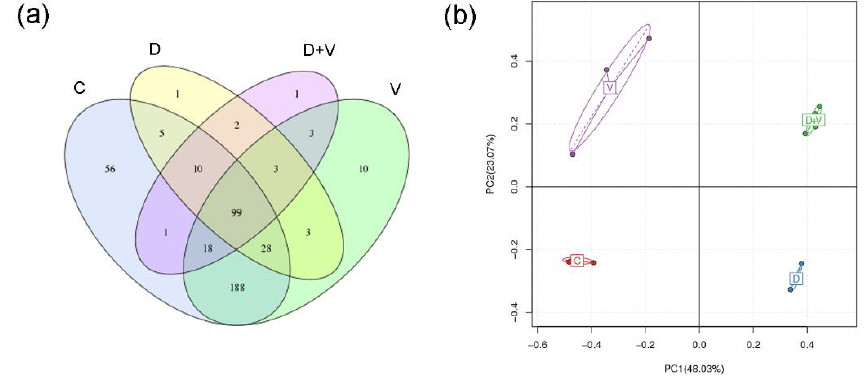
Figure 2. Operational taxonomic unit (OTU) cluster and abundance. ( a ) OTU Venn chart. Different colors represent different groups. The interior of each circle symbolically shows the number of observed OTUs in the specific group, and the intersection represents the set of OTUs commonly present in the counterpart groups. ( b ) Principal component analysis (PCA) based on OTU abundance (description). The x -axis represents the first principal component and the y -axis represents the second principal component. The number in brackets represents the contributions of principal components to differences among samples. Each sample was shown by a dot with its group color. The distance between the points in the two-dimensional (2D) graph shows their similarity, that is, the closer points had similar microbiological compositions. Group designations were as follows: control (C); virus infection model (V); dysbacteriosis model (D); dysbacteriosis and virus infection (D + V).